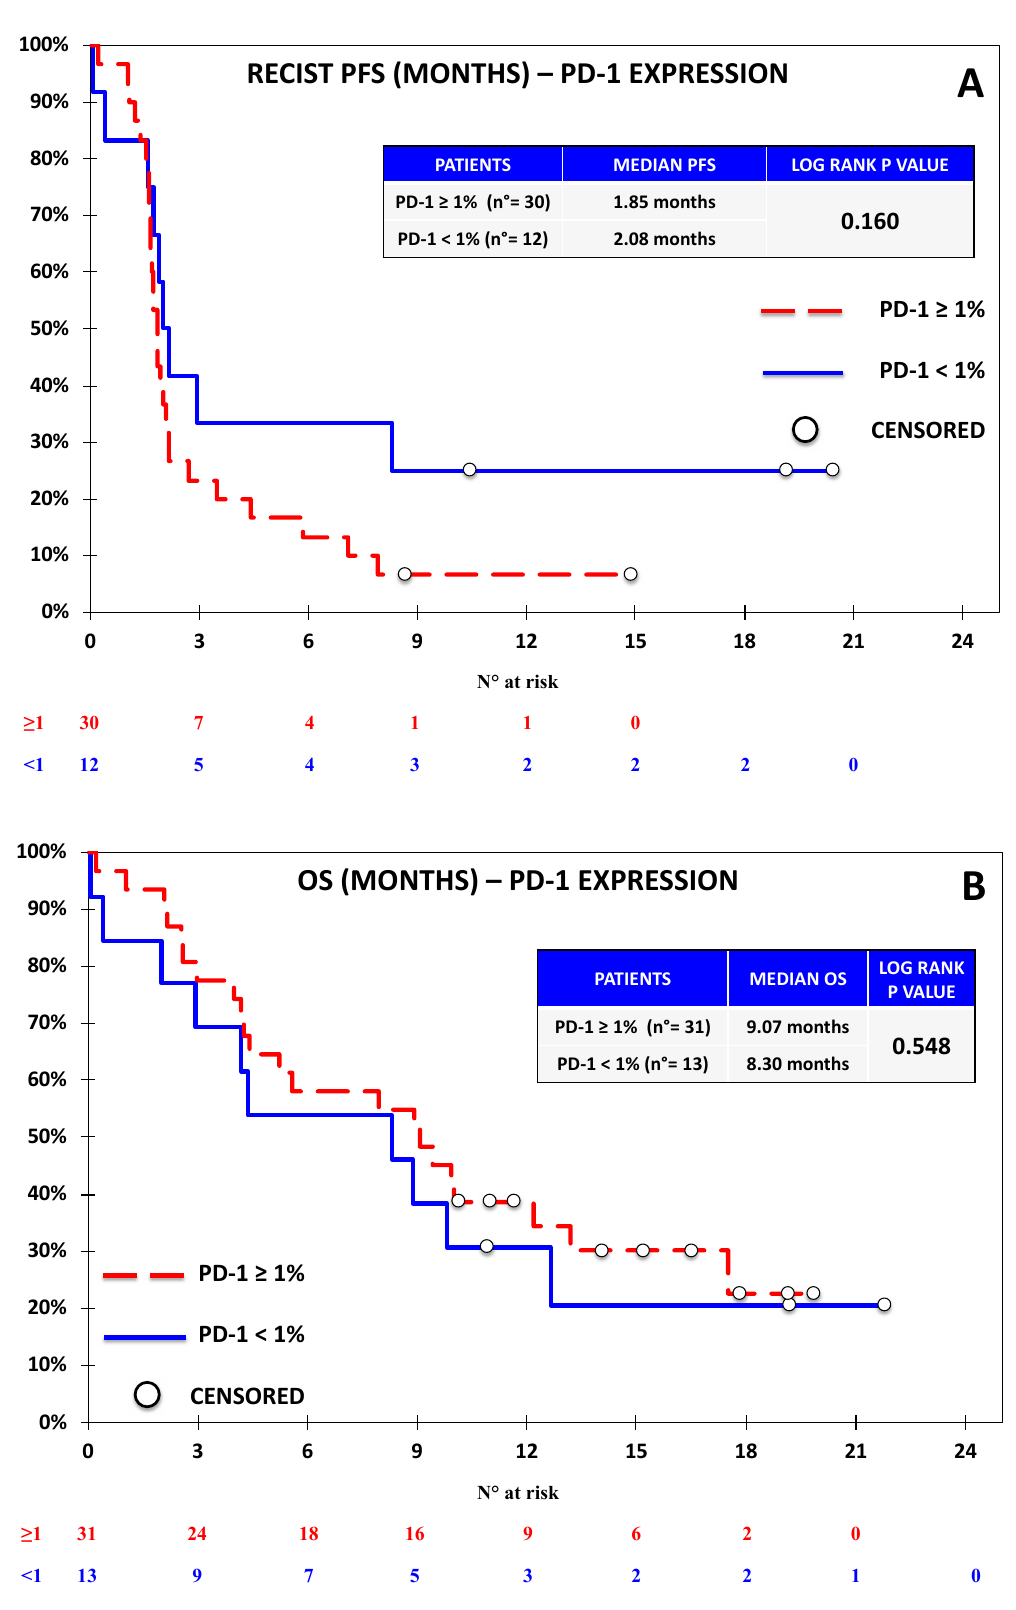
Figure 4. Kaplan–Meier curve for RECIST-PFS ( A ) and OS ( B ) based on the expression of PD-1 defined as ≥ 1% vs. <1% in the Nivolumab Cohort. No significant difference was observed on the basis of PD-1 expression.